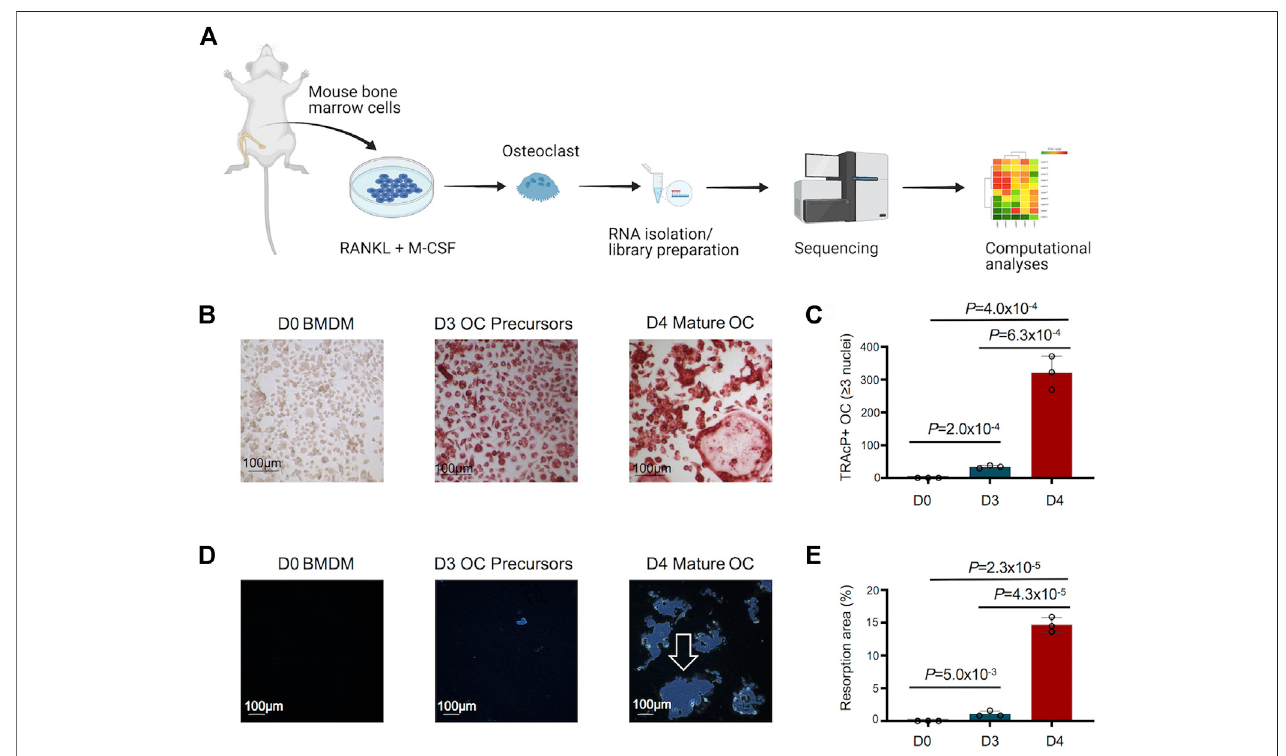
FIGURE1| Studydesign,andmorphologicalandfunctionalchangesduringosteoclast(OC)differentiation. (A) Bonemarrowcells fl ushedfromlongbonesofCBL/ 6 mice were cultured in the presence of soluble M-CSF and RANKL to induce OC differentiation. Libraries were generated from bone marrow derived macrophages (BMDM)(Day0)anddifferentiated osteoclasts atdifferenttime points(Days3and 4)toperformcomprehensiveandprogressiveanalysesofthedynamictranscriptomes of murine osteoclasts by RNA-Seq. Various bioinformatics tools were utilized for data analyses/visualization. Schematic representation of the study design is shown. (B) The generated OC were detected by staining for tartrate-resistant acid phosphatase (TRAcP). Cells positive for TRAcP staining and with more than three nuclei were identi fi ed as OC representative images of TRAcP stained cells show Bone marrow derived macrophages (BMDM) at day 0 (D0), OC precursors at D3 and mature OC at D4 of the culture. (C) Scatter/bar-hybrid plot shows the numbers with mean ± standard deviation (SD) of TRAcP+ OC in D0, D3 and D4 comparisons. (D) The bone resorption activity ofOCwasinvestigatedusing Osteo Assay.Representativeimagesshowcultures from BMDM cellsat D0, OCprecursors at D3and mature OC at D4 of the culture. Resorption areas are indicated by white arrow. (E) Scatter/bar-hybrid plot shows the differences in percentage resorption area (mean ± SD) in D0, D3 and D4 cultures.